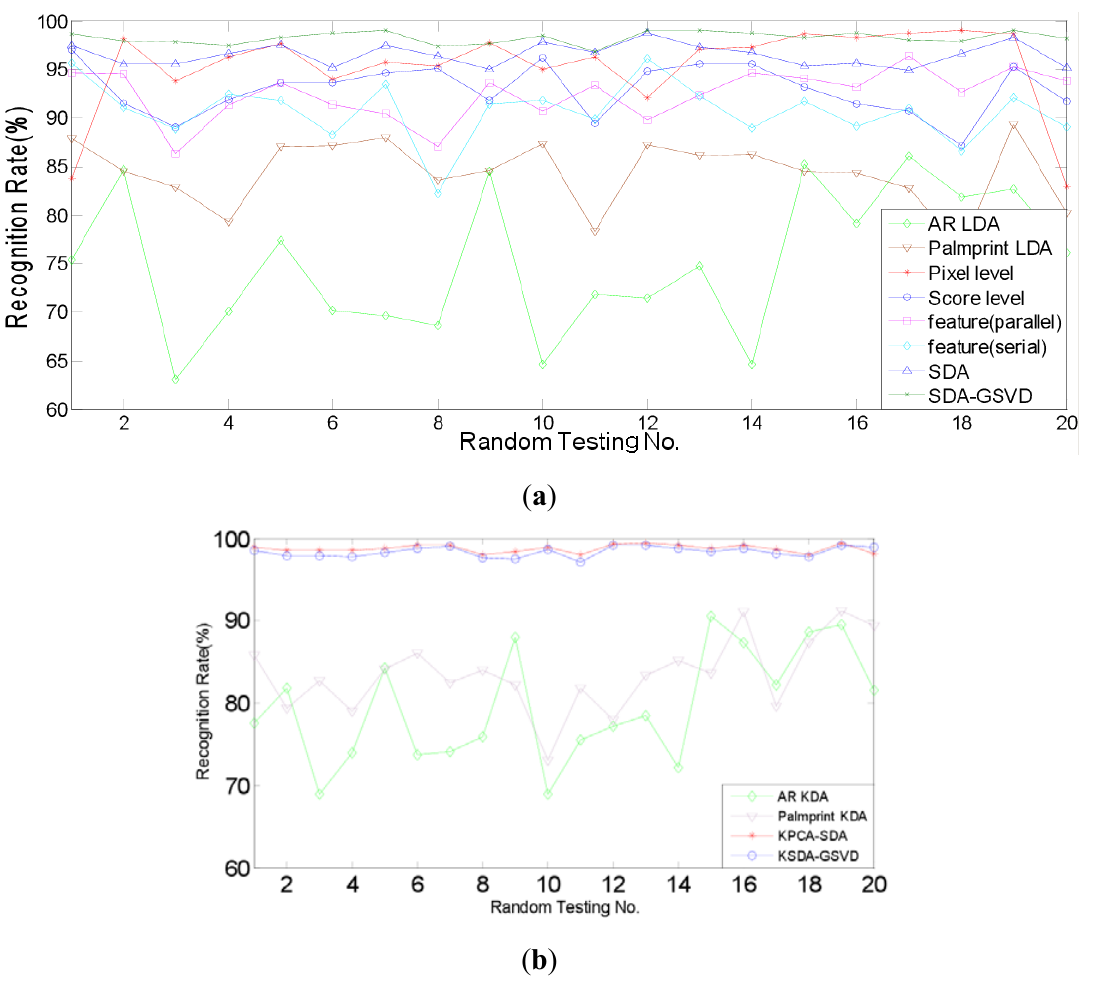
Figure 6. Recognition rates of compared methods on AR face and PolyU palmprint databases: ( a ) Linear methods; ( b ) Nonlinear